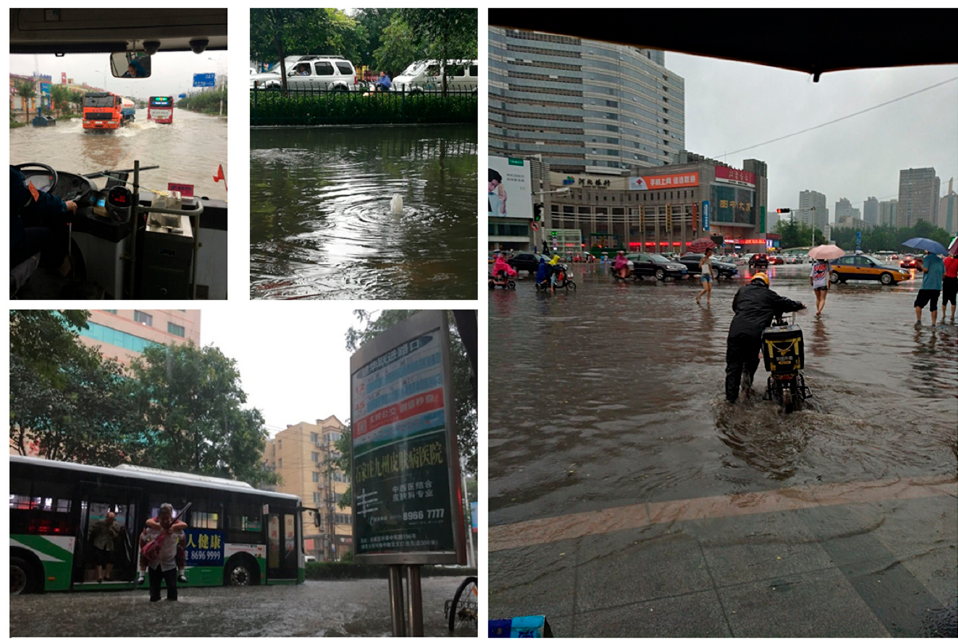
Figure 2. Urban waterlogging of Shijiazhuang caused by heavy rains in recent